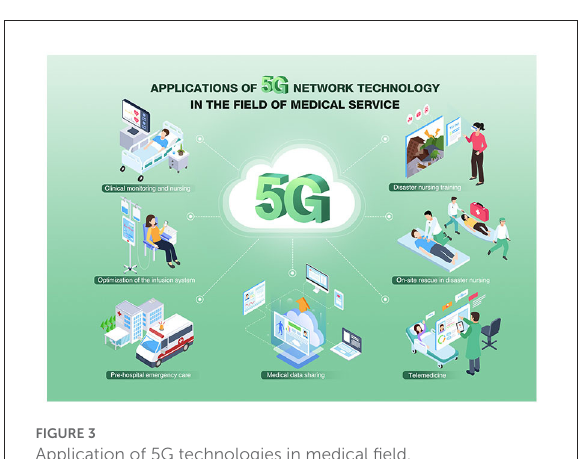
FIGURE3 Application of 5G technologies in medical